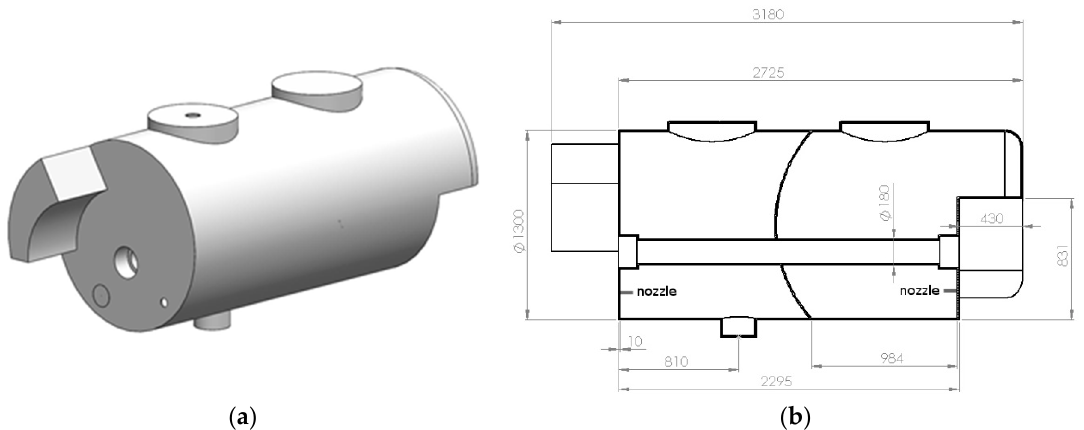
Figure 1. Geometry of the sprayer tank with 3000 L of capacity. ( a ) Exterior 3D view; *( b ) longitudinal interior 2D view. Dimensions in mm.